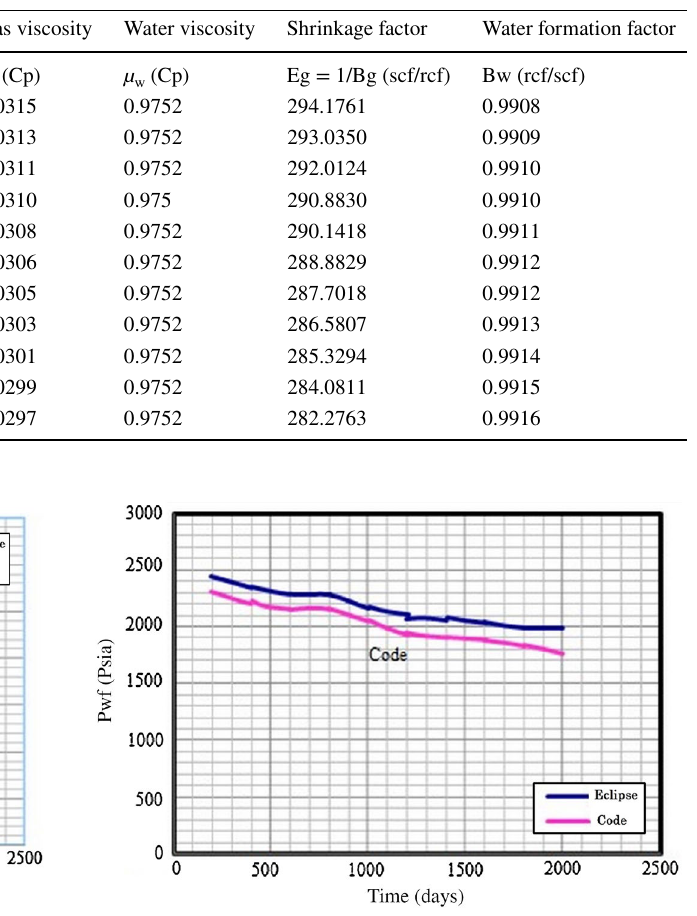
Fig. 8 Pwf versus time for well No. 1 of case #1